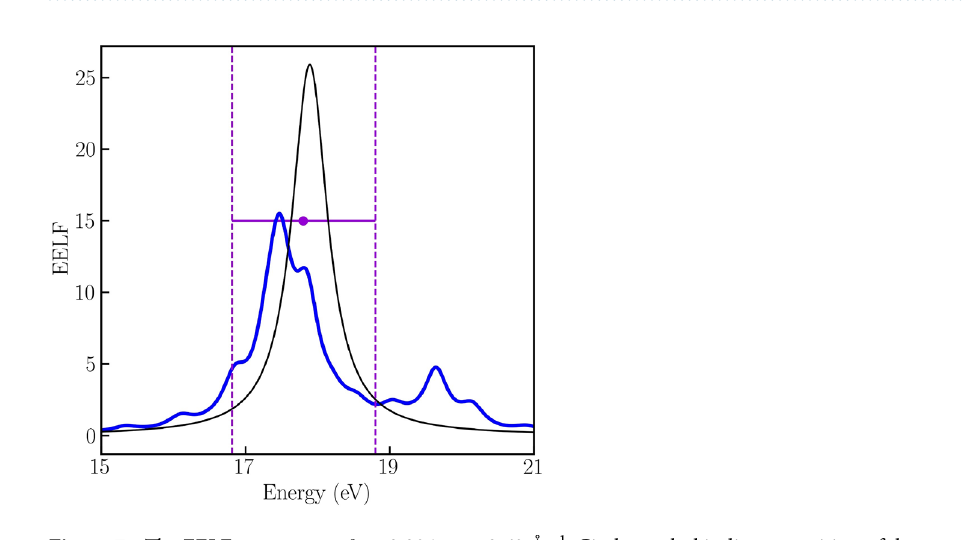
Figure 7. The EELF at U 0 = 0.1 , θ = 0.024 , q = 0.62 Å − 1 . Circle symbol indicates position of the experimentally measured plasmon location of the homogeneous WDM 84 . Vertical dashed curves correspond to uncertainty range in the experiment. The solid black curve illustrates the plasmon mode, i.e., the EELF of the uniform electron gas. The EELF of the inhomogeneous state (along wave vector Q ) is illustrated as the solid blue